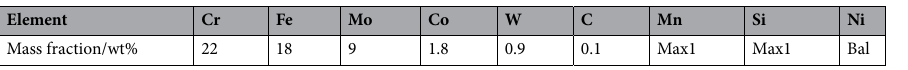
Table 1. Chemical composition of the GH3536 powder.